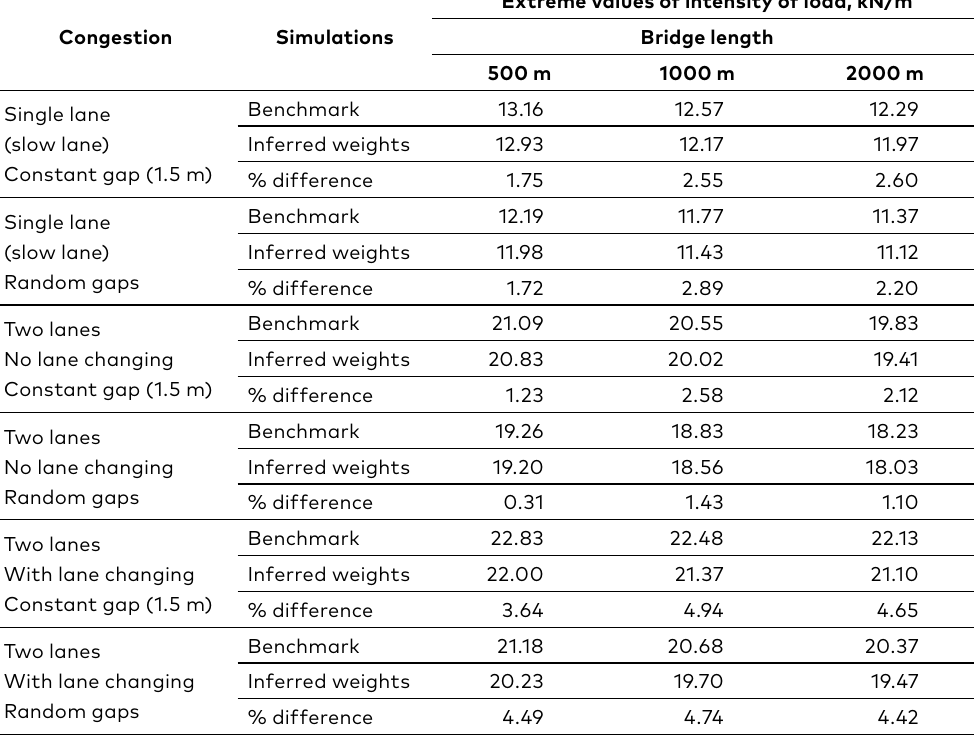
Table 2. Extreme values (75-year return period) for load intensity according to the number of lanes and gap